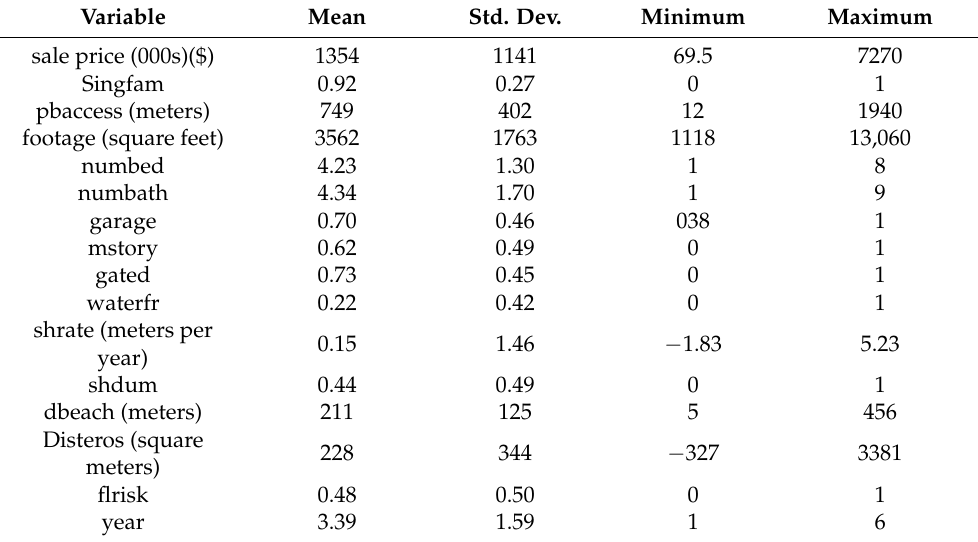
Table 2. Descriptive statistics of the sale prices of the homes sold in the study area and their structural, locational, and environmental